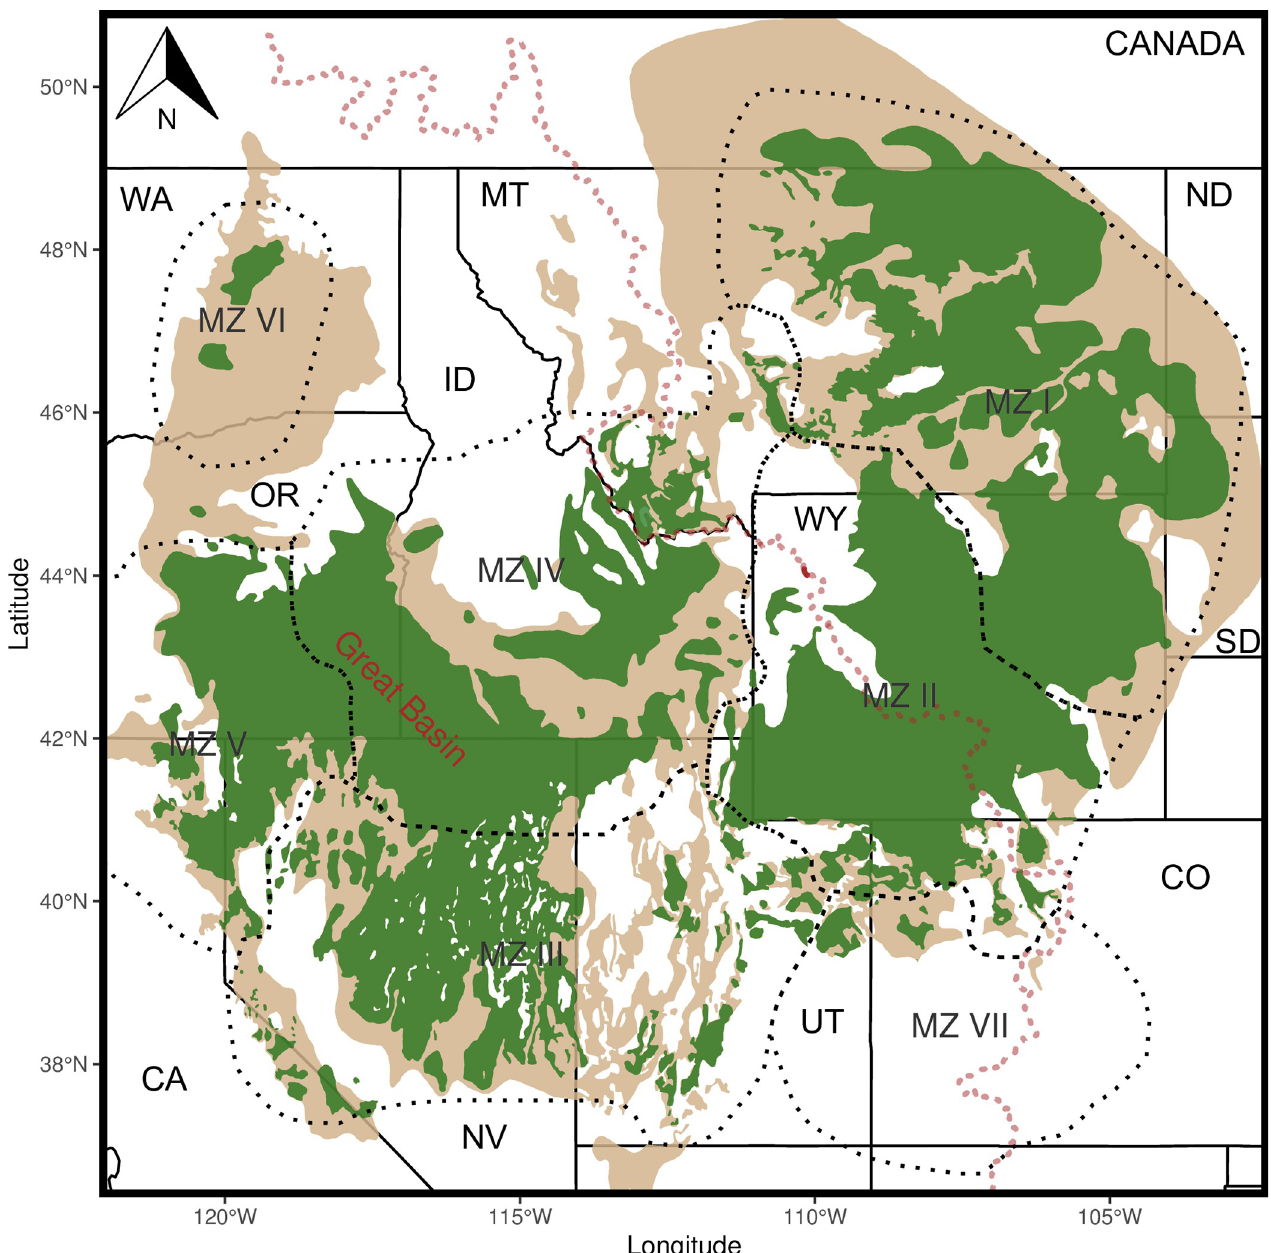
Fig 1. Current (dark green) and pre-settlement (tan) distribution of Greater Sage-grouse ( Centrocercus urophasianus ) in the western part of North America. (distribution layers available at https://www.sciencebase.gov/catalog/item/52e17ac3e4b0d0c3df9a3968 and https://www.sciencebase.gov/catalog/ item/543d9947e4b0fd76af69cc74). The dotted red line represents the Continental Divide. Dotted black lines represent the seven sage-grouse management zones (MZ). State names are represented by the following abbreviations California (CA), Colorado (CO), Idaho (ID), Montana (MT), Nevada (NV), North Dakota (ND), Oregon (OR), South Dakota (SD), Utah (UT), Washington (WA), and Wyoming